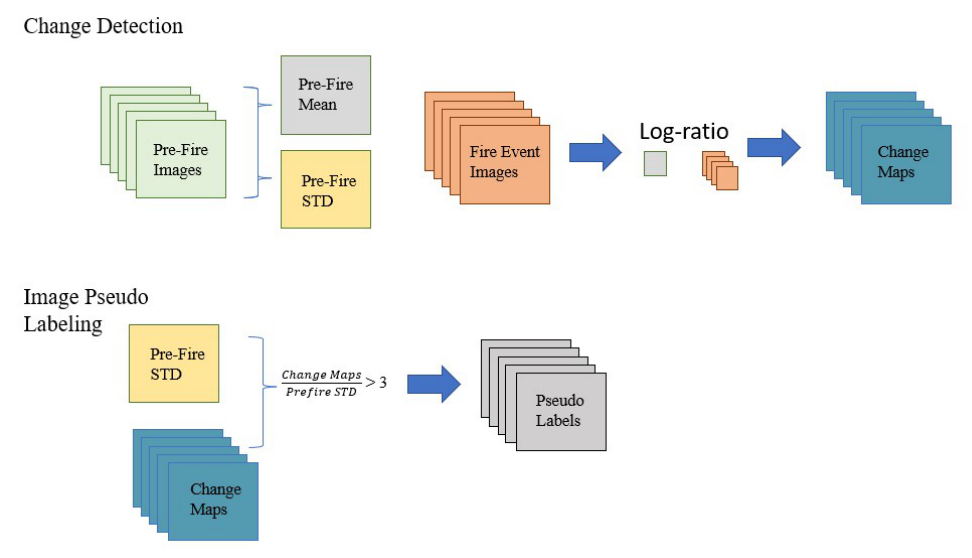
Figure 5. Graphical depiction of the methodology for SAR change detection and pseudo label gen- eration.